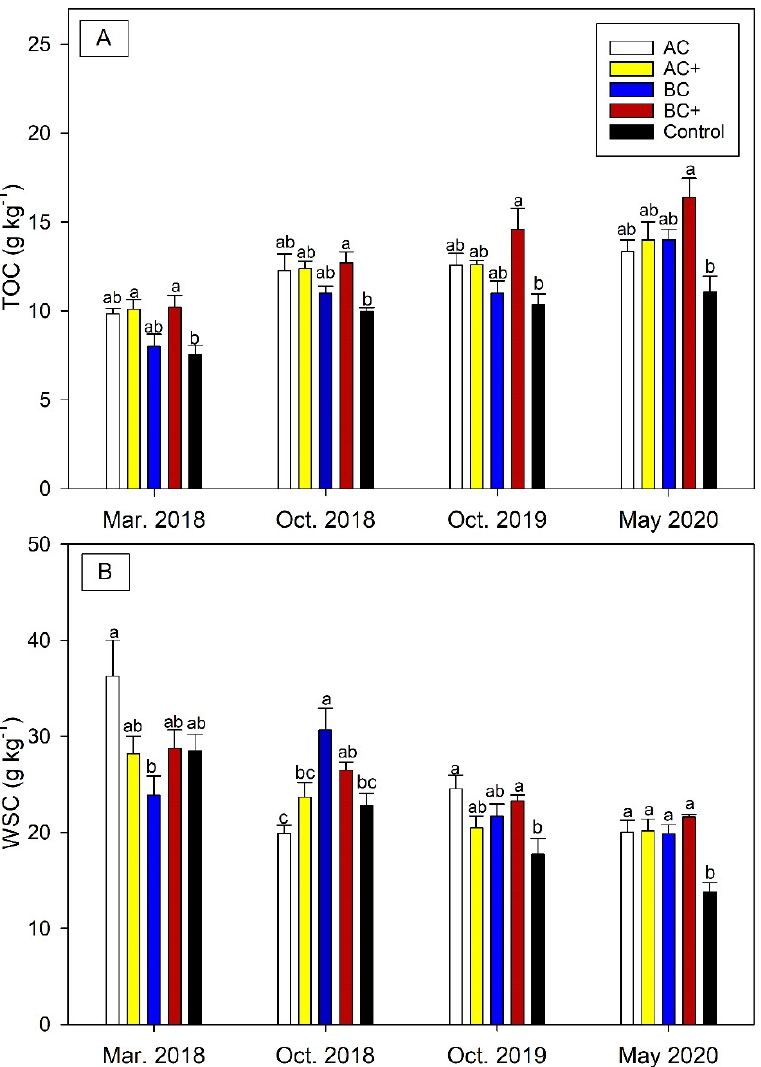
Figure 1. Evolution of ( A ) total organic carbon (TOC) and ( B ) water soluble Carbon (WSC) in soil during the 3 years of the experiment under different treatments: AC (Balperujo compost), AC+ (high dose of alperujo compost), BC (biosolid compost) and BC+ (high dose of biosolid compost). The same lowercase letters indicate no significant difference ( p > 0.05) between treatments within each year. Data are mean values ± standard error of the mean (SEM).